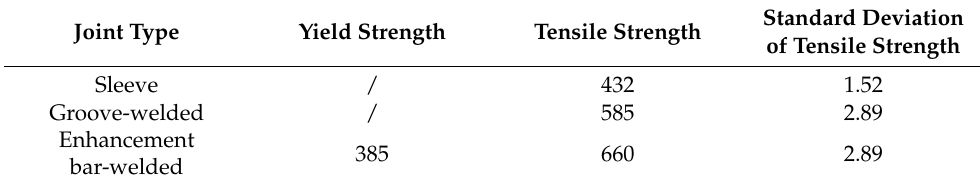
Figure 15. Fracture position for each rebar: ( a ) sleeve connection, ( b ) groove-welding connection, and ( c ) enhancement bar-welding connection. Table 9. Results of the tensile test for each joint (wt. MPa).